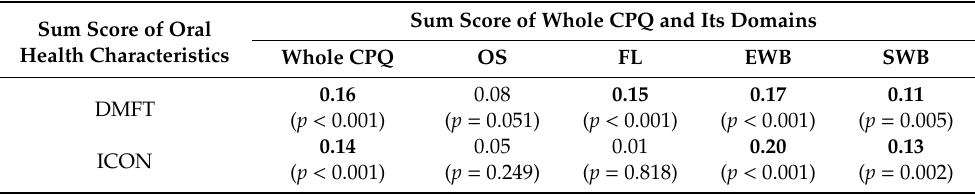
Table 2. Spearman correlation coe ffi cients between the clinical characteristics of oral health and the CPQ sum score ( N = 600).